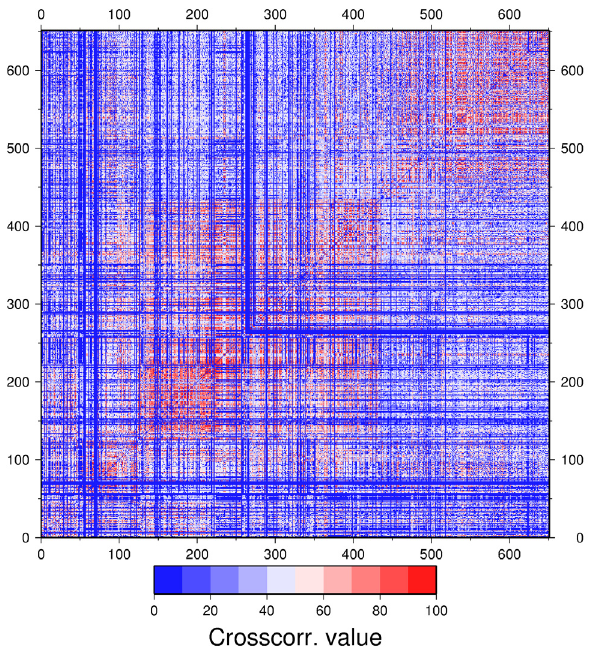
Figure 6. Cross-correlation matrix for the 651 events classified as quarry blasts in the Cingoli area in the period August 2009 - December 2012. Red colors represent high similarity. Different families are rec- ognizable, confirming the evolution in time of the quarry activity.